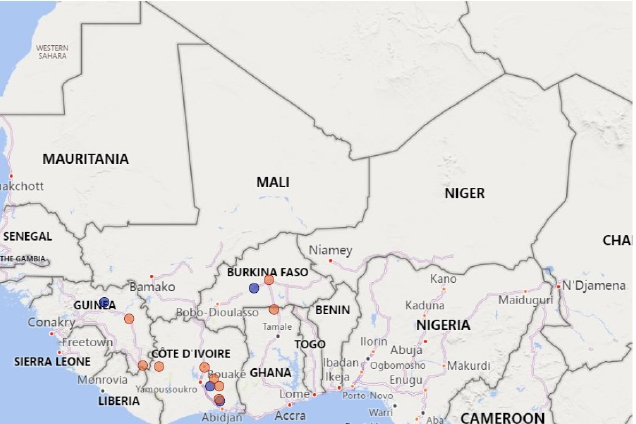
Figure 1. Map showing the sampling locations of PPR-positive samples. Lineage II and IV viruses are indicated by blue and red circles, respectively.